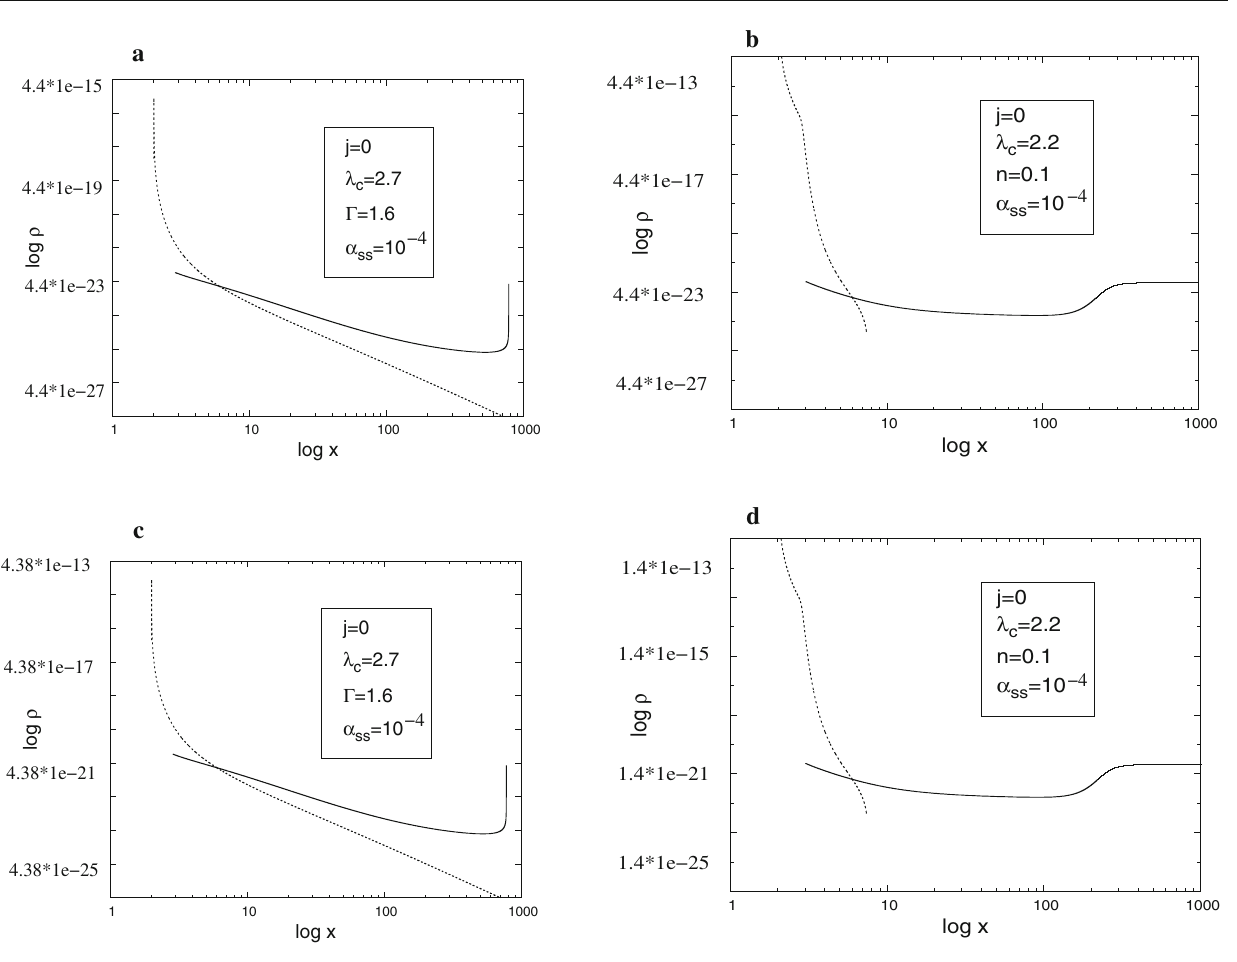
Fig. 3 a , c Plotsof log (ρ) vs log ( x ) fornonviscous accretiondiscflow around a non-rotating BH for adiabatic case using NFW and Einasto profile respevctively. b , d Plots of log (ρ) vs log ( x ) for viscous accre-